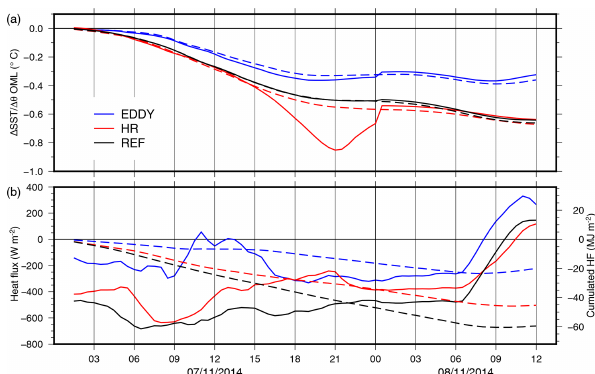
Figure 11. Time series of the SST (solid line) and potential temper- ature in the OML (dashed line) (a) and instantaneous (solid line, left-hand-side scale) and integrated downward heat flux (dashed line, right-hand-side scale) (b) in the EDDY (blue), HR (red), and REF (black) zones (see